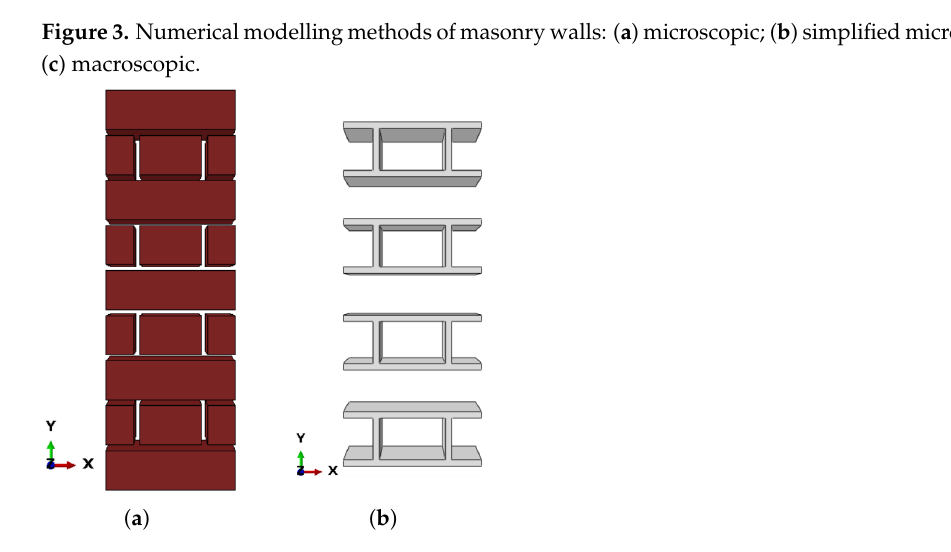
Figure 4. Micro-modelling approach for computational simulations: ( a ) brick units and ( b ) mortar